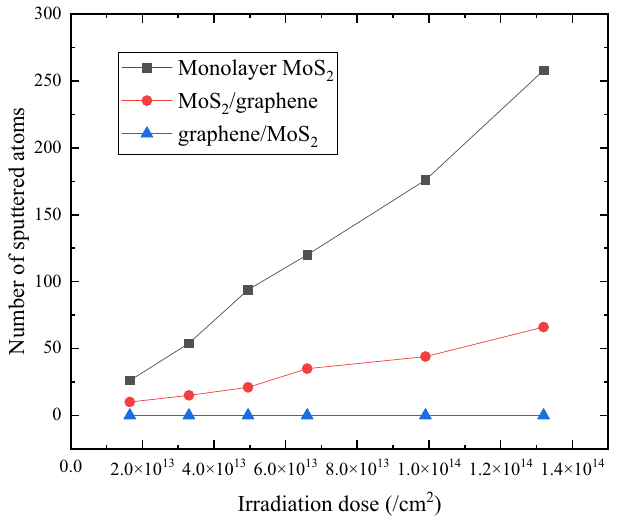
Figure 6. Dependence of the number of sputtered atoms on irradiation dose for three study cases. The irradiation energy is 100